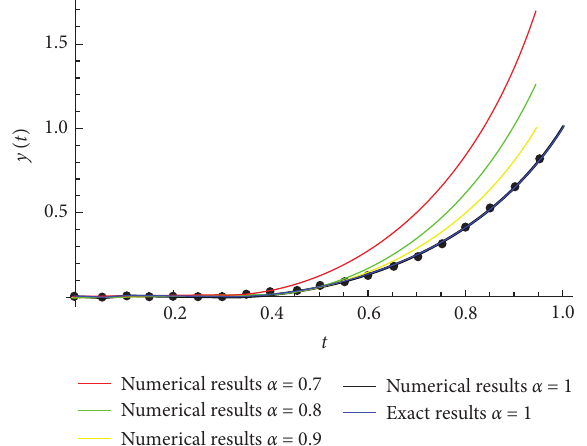
Figure 11: Numerical solutions (different α ) and exact solution ( α � 1 ) with m � 4 , n � 6 for Example